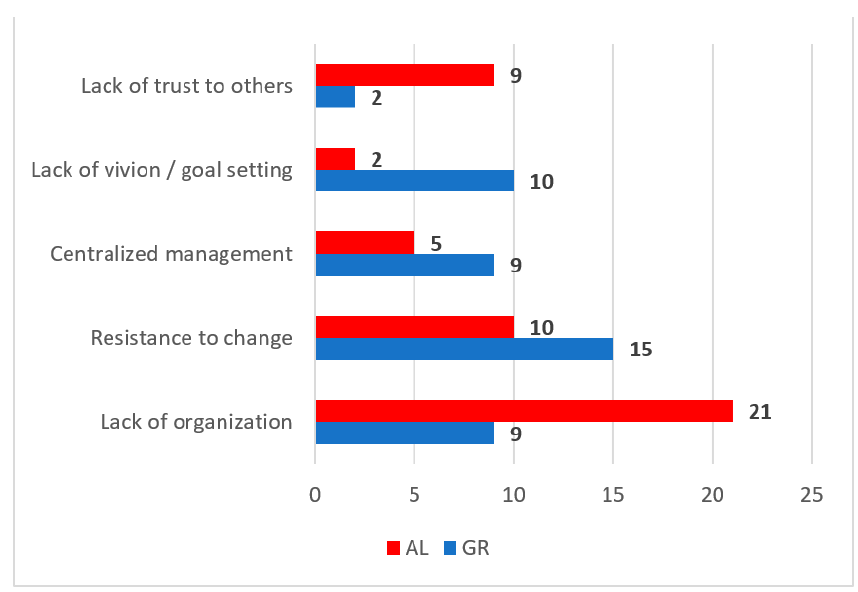
Figure 5. Business acceleration program contribution on improving organizational weaknesses.